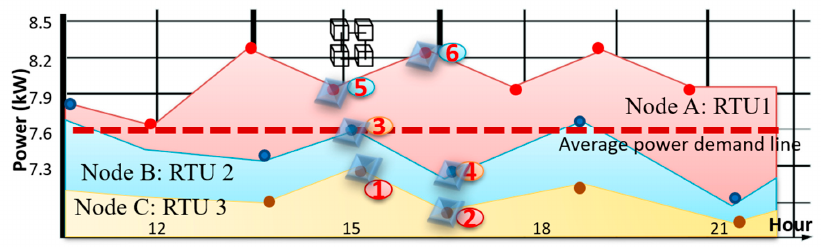
ff erent nodes of smart Figure 8. Chosen power data of different nodes of smart RTUs . Figure 8. Chosen power data of di